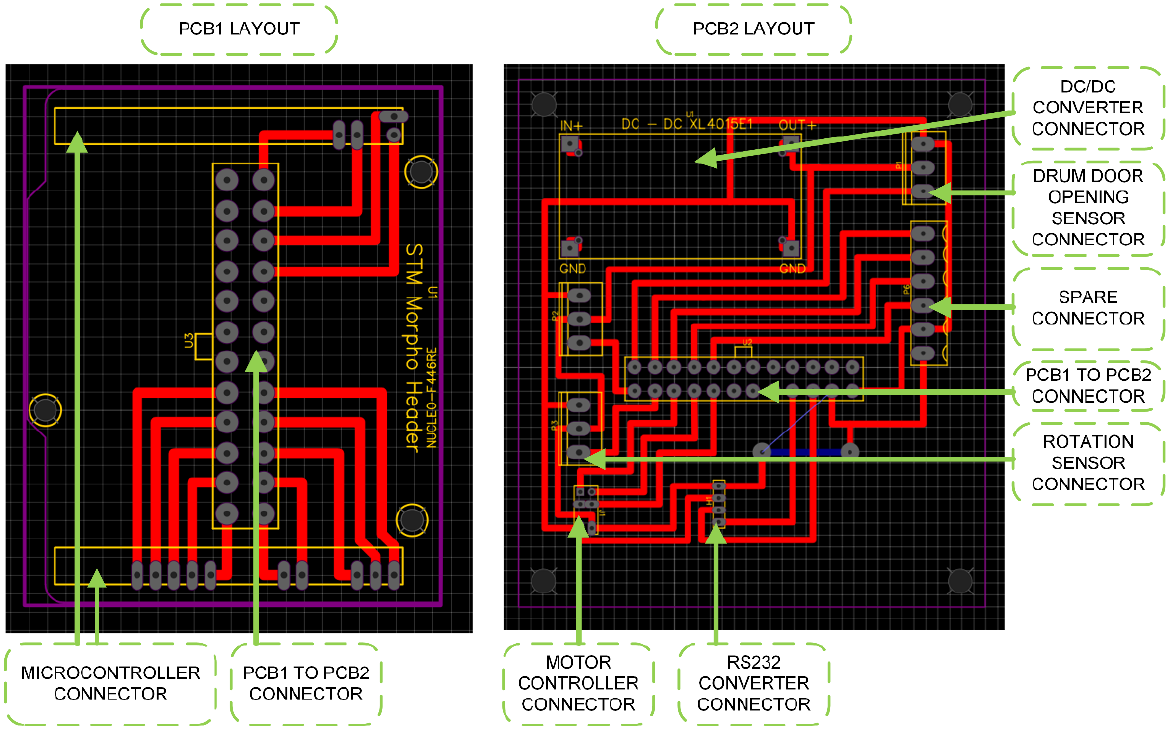
Figure 5. Detailed block diagram of the electrical part developed with the IoTT ‐ enabled washing machine demonstrator and connected sensors.